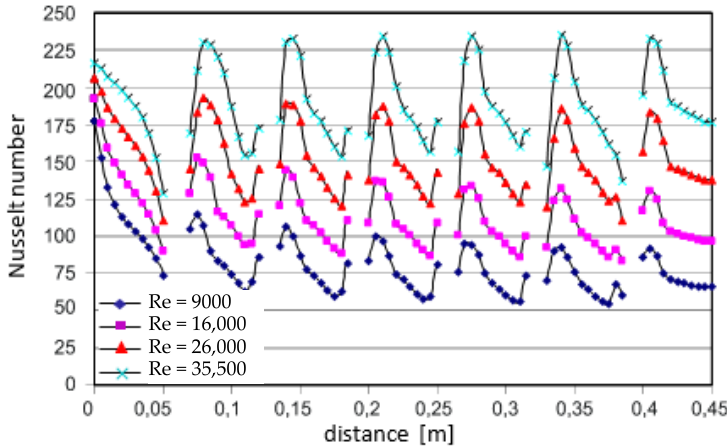
Figure 17. Local Nusselt number distribution for different Re numbers for a channel with perpendicular ribs on the bottom surface of the channel (configuration_1).